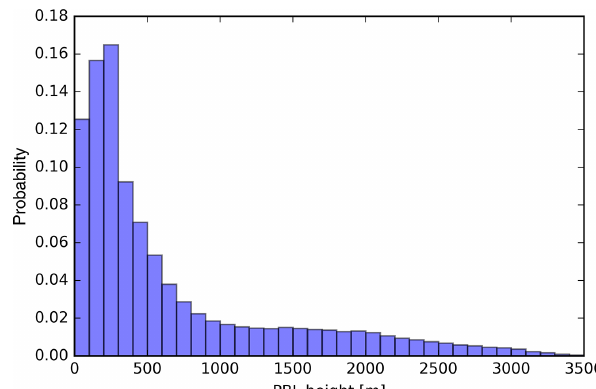
Figure 1. Frequency distribution of PBL heights occurring dur- ing the 5-day backward simulation from 19 July 2014, 00:00UTC